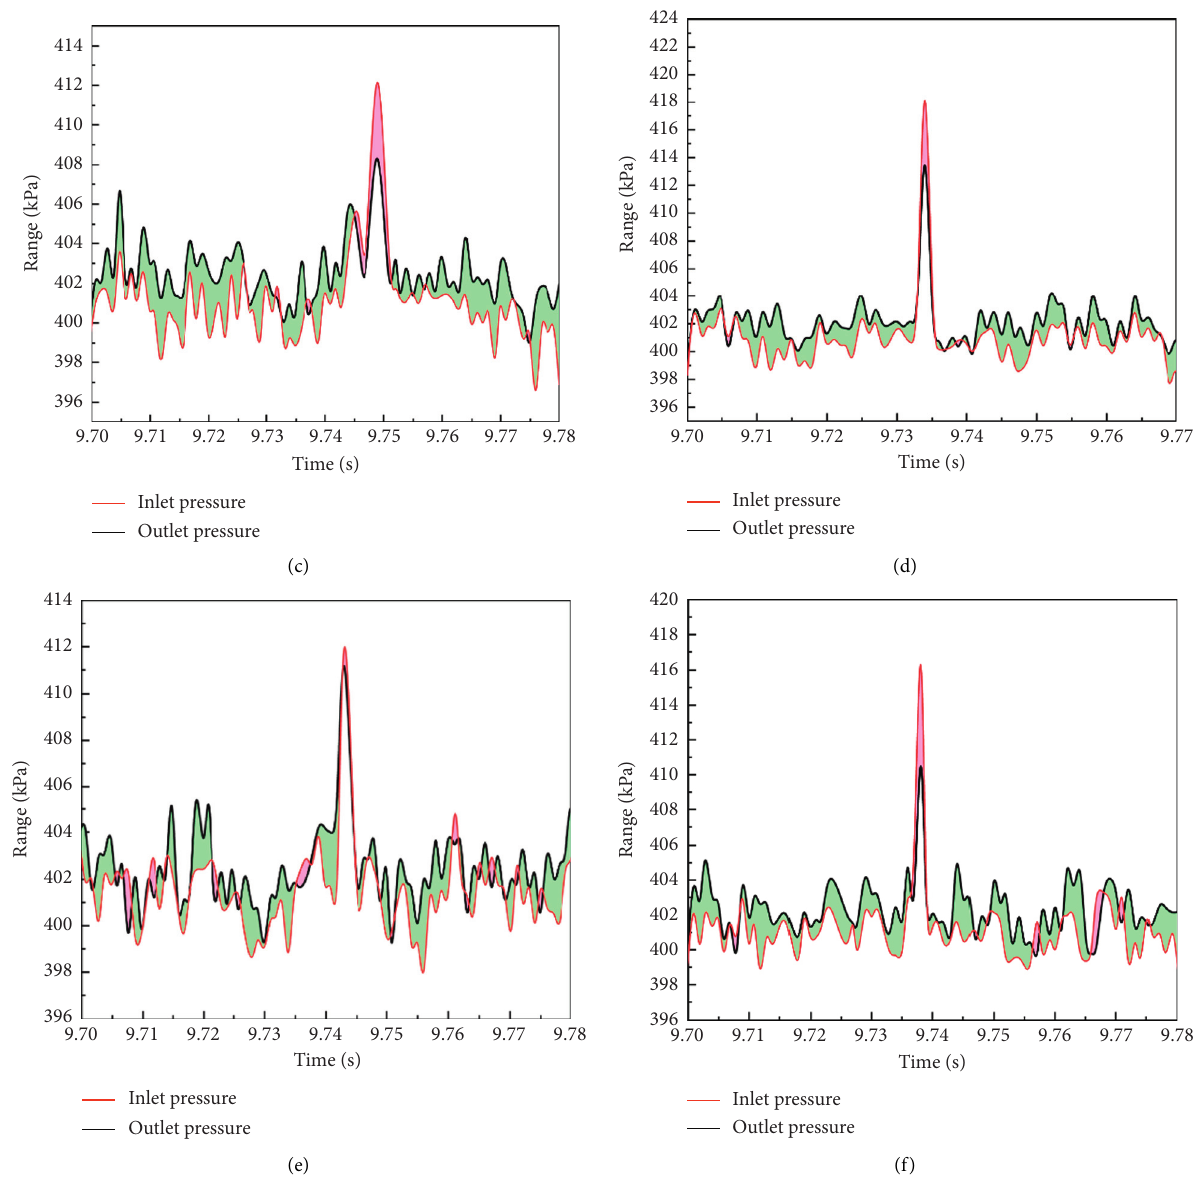
Figure 10: Experimental pressure detection charts (a), (b), (c), (d), (e), (f), and (g) show the pressures of air (a) and gas concentrations of 1.10%, 1.20%, 1.30%, 1.40%, and